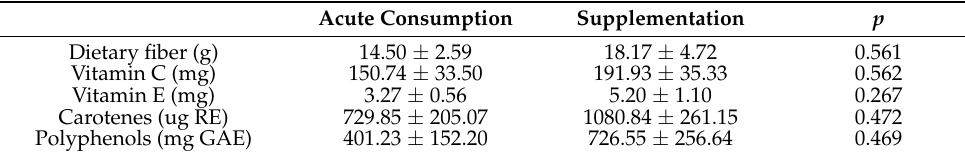
Figure 2. Glucose and insulin results after acute fresh blueberry consumption (Ac). ( A ) Basal fasting glucose levels. ( B ) Basal fasting insulin levels. ( C ) Glucose curve after 150 g of white bread consumption. ( D ) Insulin curve after 150 g white bread consumption. ( E ) Area under the curve (AUC) of plasma glucose after 150 g of white bread consumption. ( F ) Area under the curve (AUC) of plasma insulin after 150 g of white bread consumption. * p < 0.05 vs control or t = 0, ** p < 0.01 vs control or t = 0. Table 1. Dietary intake of fiber and antioxidants in sedentary subjects on the day of acute consumption and supplementation experiments (Median ±